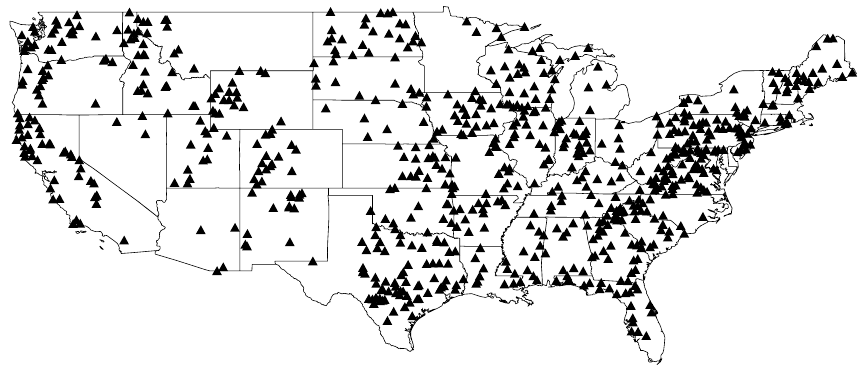
Fig. 1. Location of all the 756 catchments (black triangles) within the continental